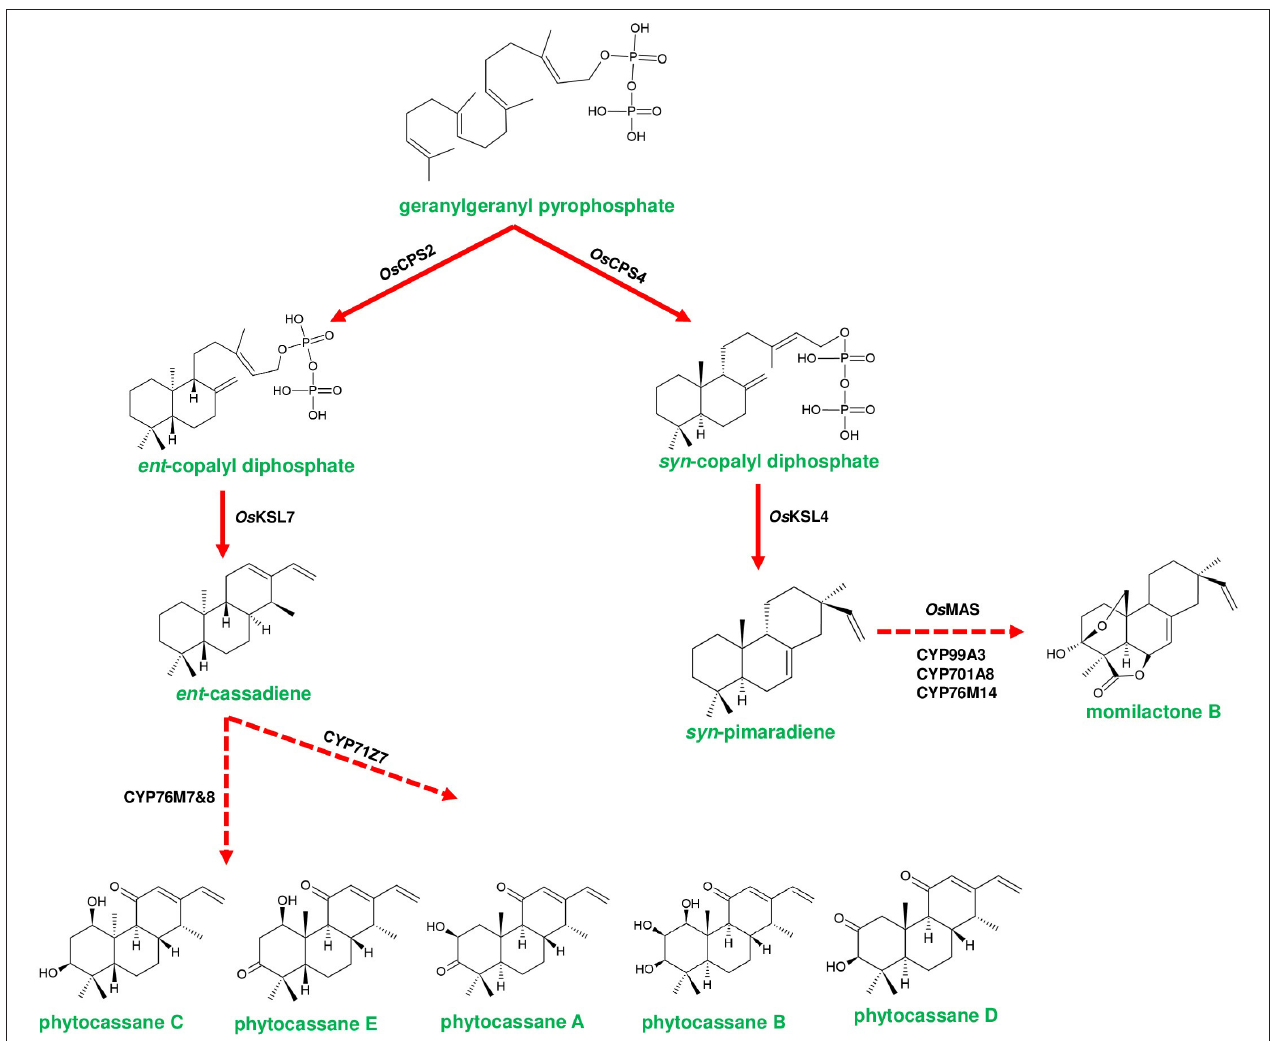
FIGURE 4 | Representative biosynthetic pathway of phytoalexins in Oryza sativa (rice). Phytocassanes bioproduction is initiated by the conversion of geranylgeranyl pyrophosphate (GGPP) to ent -copalyl diphosphate ( ent -CDP) by OsCPS2 (copalyl diphosphate synthase 2). ent -CDP is converted to ent -cassadiene by OsKSL7 (kaurene synthase like 7). ent -cassadiene is converted to different derivatives of phytocassanes by CYP450s. Momilactone biosynthesis is initiated by the conversion of GGPP to syn -copalyl diphosphate ( syn -CDP) through OsCPS4. syn -CDP is converted to syn -pimaradiene by OsKSL4. syn -pimaradiene is converted to momilactone through the reactions mediated by CYP99A2/A3, CYP701A8, CYP76M14 and short-chain alcohol dehydrogenase (momilactone synthase; OsMAS). Dotted arrows represent a multi-step